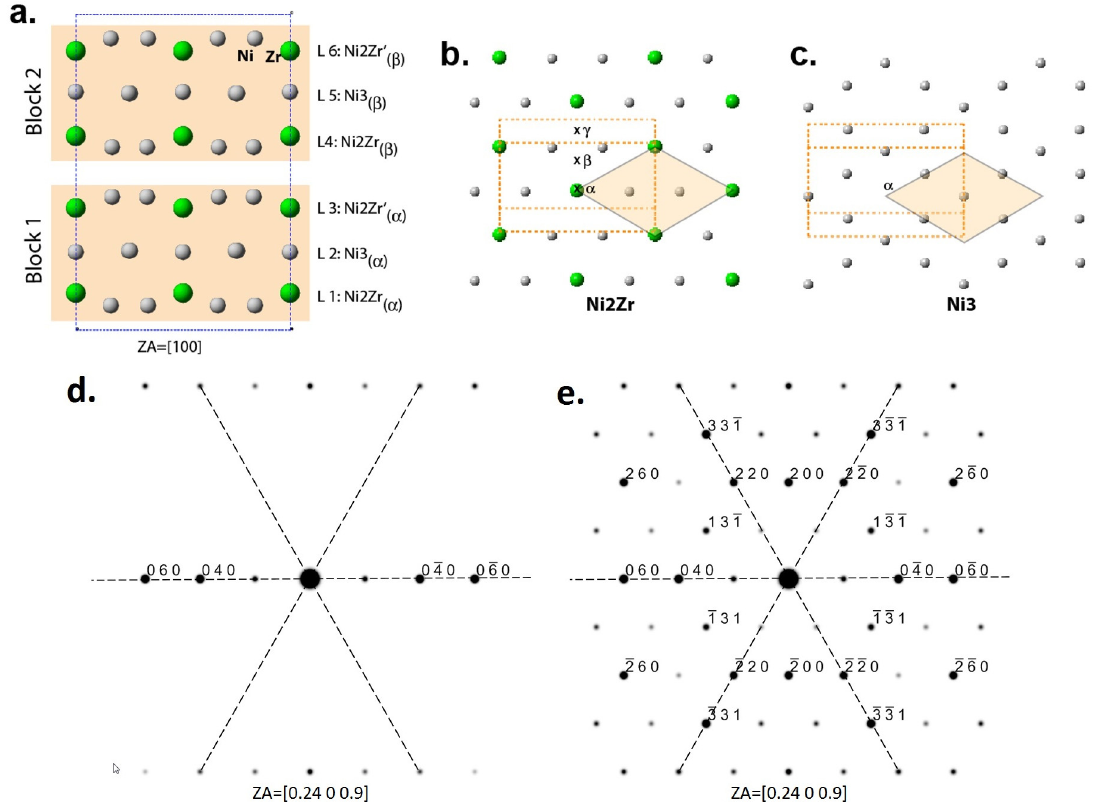
Figure 7. A projection of the Zr 2 Ni 7 structure in the [100] direction ( a ), projections of the layers from ( a ) with an outlined pseudo-hexagonal unit cell ( b , c ) and simulated SAED patterns with the electron beam’s direction normal to the layers’ planes (ZA = [0.24 0 0.9]) for very thin (1 nm) ( d ) and thicker (10 nm) ( e ) Zr 2 Ni 7